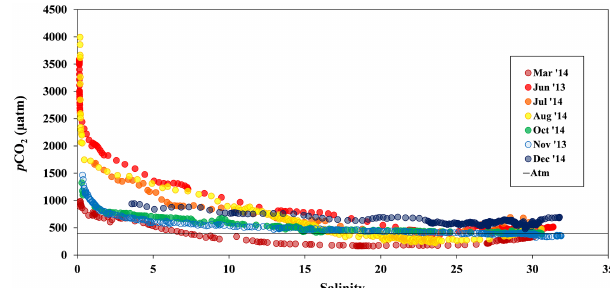
Figure 7. Measured surface water p CO 2 against the salinity gradi- ent during each sampling month in the Delaware